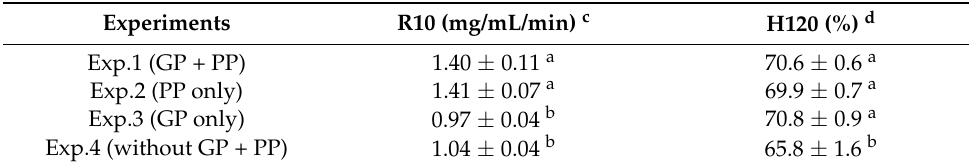
Figure 5. In vitro starch hydrolysis curves of cooked samples of control INCs from four experiments differing in protease combinations. Symbols ( • , (cid:52) , , ) represent the four experiments (see Ex- perimental Section 2.5.2). Errors bars represent the standard deviations. Abbreviations: GP—gastric pepsin, PP—pancreatin proteases. Table 3. Kinetic parameters of in vitro starch digestion of cooked samples of control INCs from four experiments differing in protease combinations.